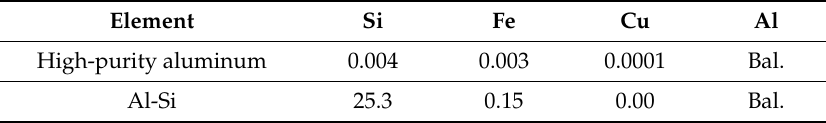
Figure 1. Scheme of the casting process for the master alloy. Table 1. Chemical composition of raw materials (wt.%).